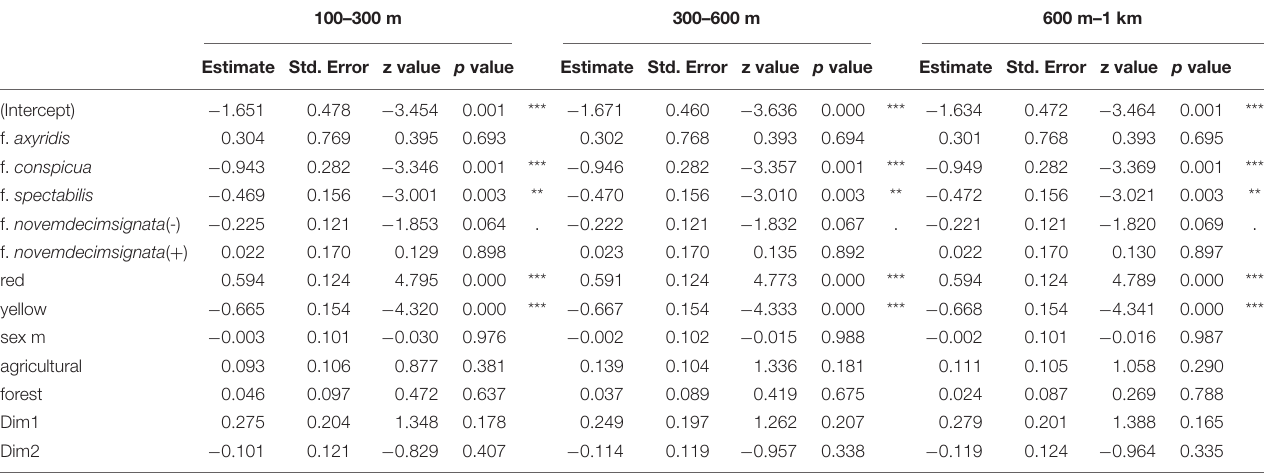
TABLE 3 | Obtained parameters of each candidate model addressing the prevalence of infection by Hesperomyces virescens for different annulus radii (100–300 m, 300–600 m, 600 m–1